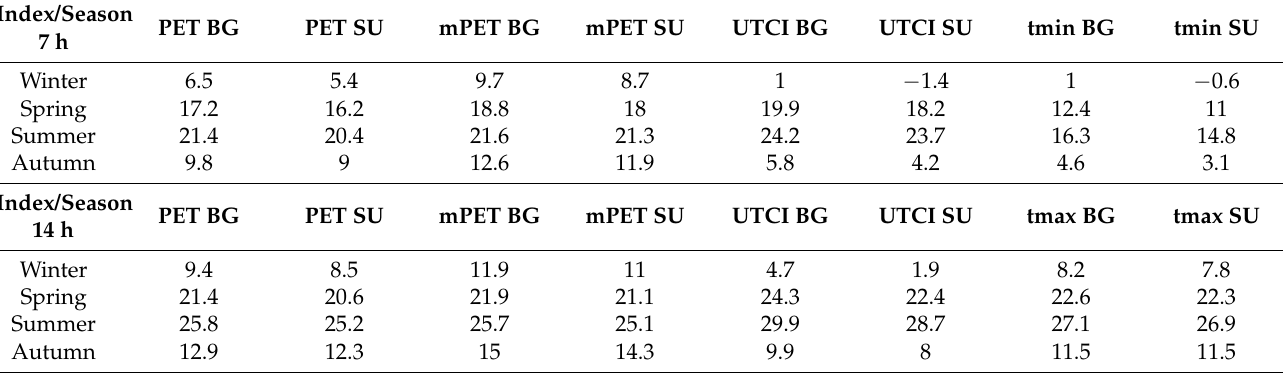
Table 4. Average seasonal PET, mPET and UTCI in Belgrade (BG) and Surcin (SU) for the period 1976–2018 at 7 h and 14 h